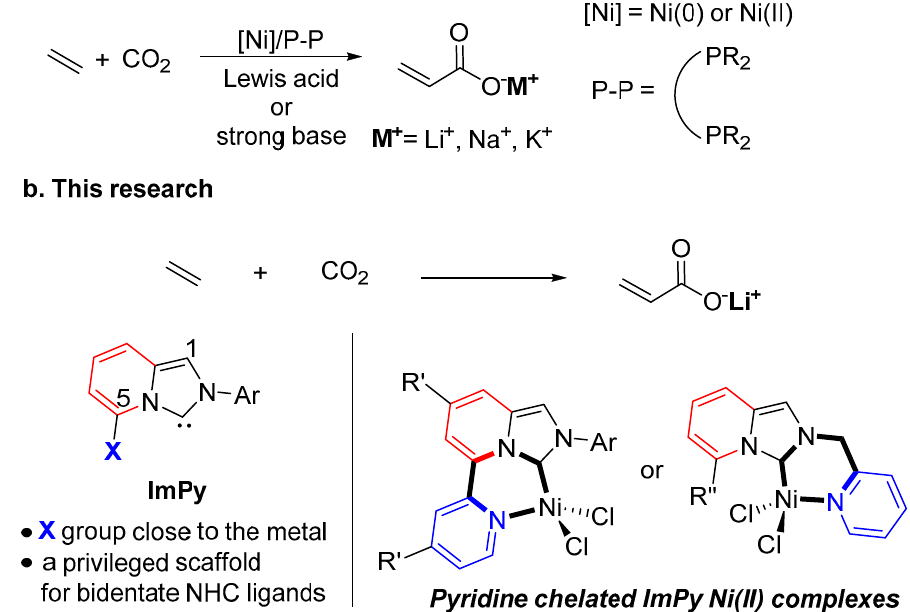
Figure 1. ( a ) One-pot catalytic systems for acrylate synthesis from ethylene and CO 2 [32–34]; ( b ) this research: pyridine chelated ImPy Ni(II) complexes for acrylate synthesis from ethylene and CO 2 . 2. Results and Discussion.